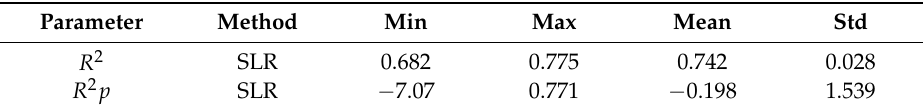
Table 2. Parameters for SLR performance